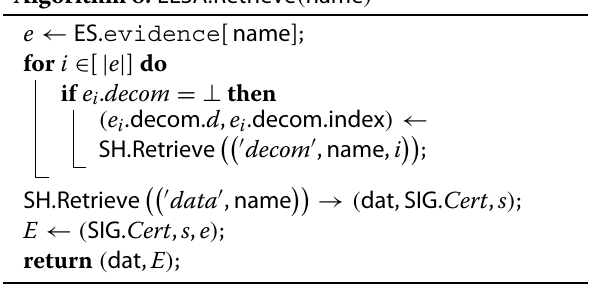
Algorithm 8: ELSA . Retrieve ( name ) Algorithm 9: ELSA . Verify ( name , t store